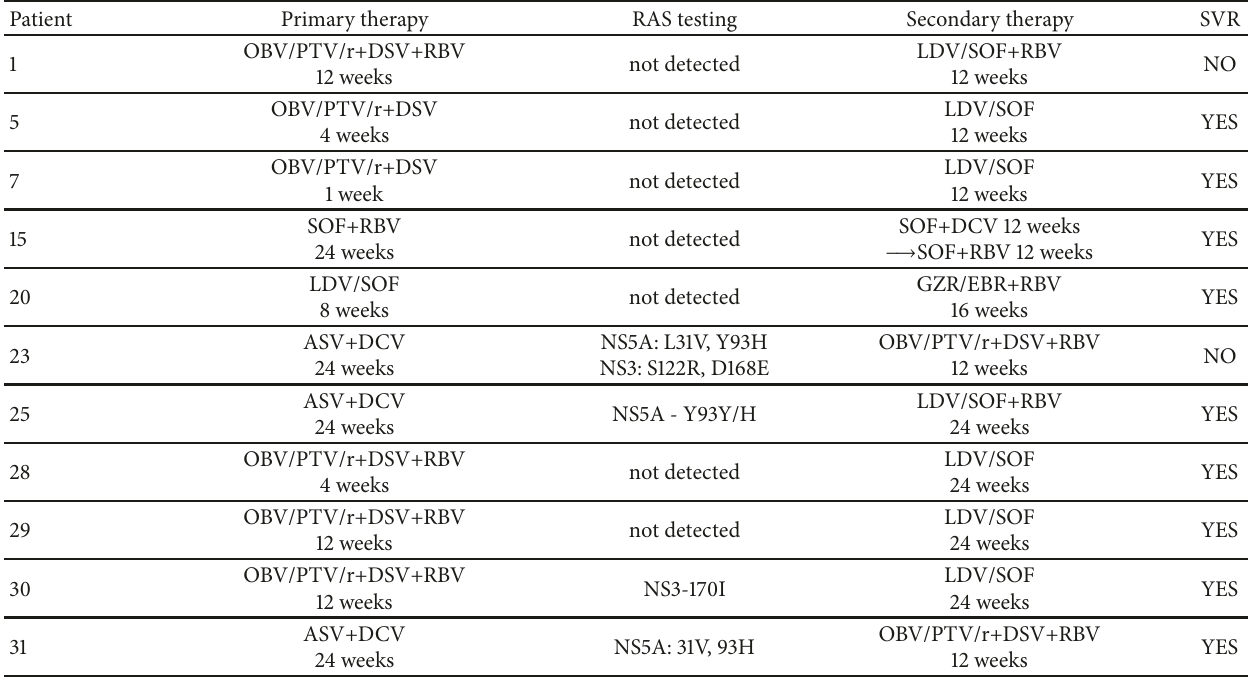
Table 4: Patients with known RAS